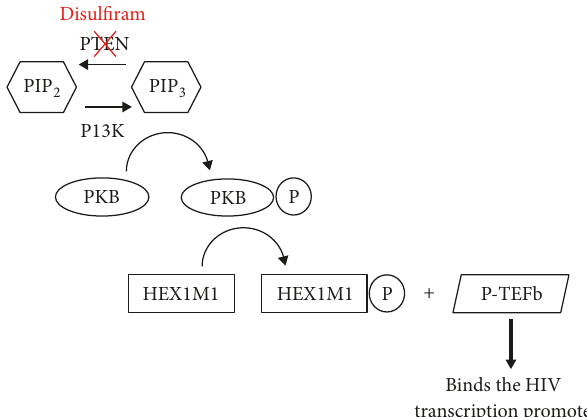
Figure 1: The mechanism of disulfiram activation of HIV tran- scription. Disulfiram activates the PKB/Akt signalling pathway by depleting PTEN (see Doyon et al.